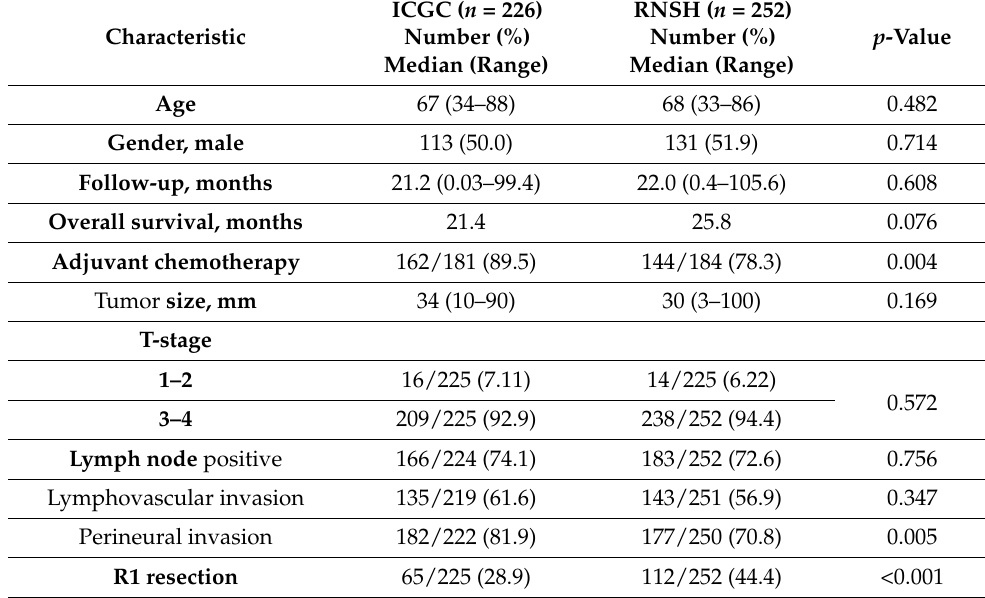
Table 1. Baseline characteristics of the ICGC and the RNSH